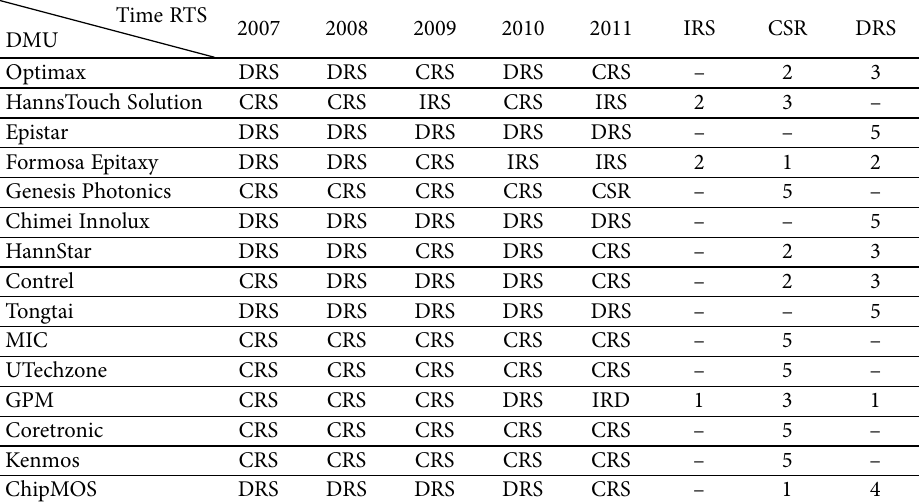
Table 7. 2007–2011 DMU returns to scale